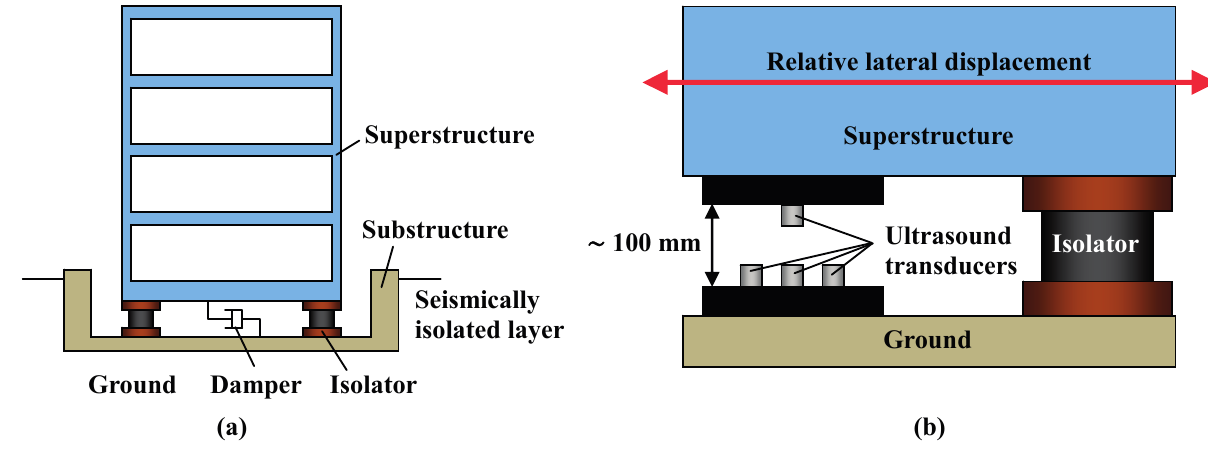
Figure 1. ( a ) Seismically isolated building; ( b ) Enlarged view of the seismically isolated layer and installation of ultrasonic lateral displacement